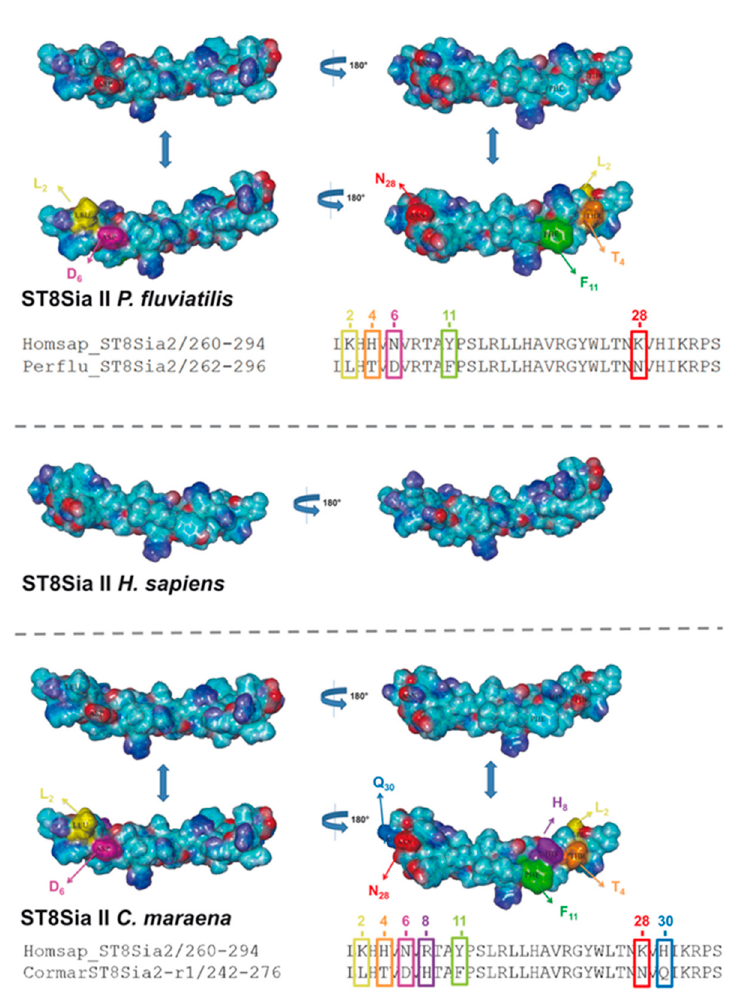
Figure 8. Three-dimensional (3D) structure of PSTD motifs in fish ST8Sia II. The 3D model of human ST8Sia II PSTD in addition to PSTD from P. fluviatilis and C. maraena was simulated, based on the 3D model of human ST8Sia IV PSTD (Protein Data Bank entry 6AHZ) using YASARA. The electrostatic potential surfaces are displayed. The exchanged amino acids are colored in an additional version of the 3D structure to highlight the position of the exchange: K2 → L2 (yellow), H4 → T4 (orange), N6 → D6 (magenta), Y11 → F11 (green), and K28 → N28 (red) for P. fluviatilis and K2 → L2 (yellow), H4 → T4 (orange), N6 → D6 (magenta), R8 → H8 (violet), Y11 → F11 (green), K28 → N28 (red), and H30 → Q30 (light blue) for C. maraena . For the determination of the 3D structure of human ST8Sia IV PSTD, a peptide with one additional amino acid on the N-terminus and two additional amino acids on